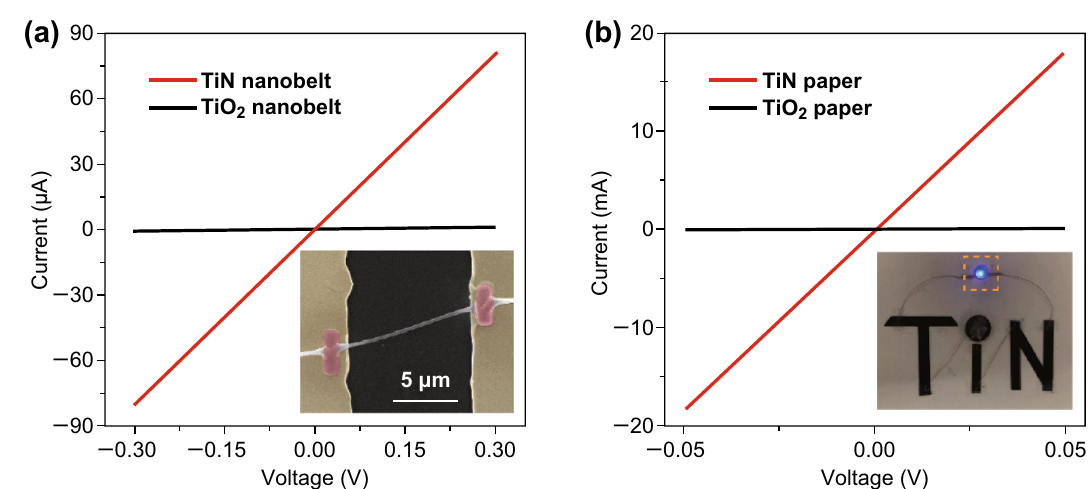
Fig. 3 a I – V curves of individual ultralong TiO 2 and TiN nanobelts. Inset shows the SEM image of a single nanobelt test unit. b I – V curves of TiO 2 and TiN papers. Inset shows the digital image of TiN papers as a part of the electrical connections to light a blue LED by a commercial 3 V battery. (Color figure